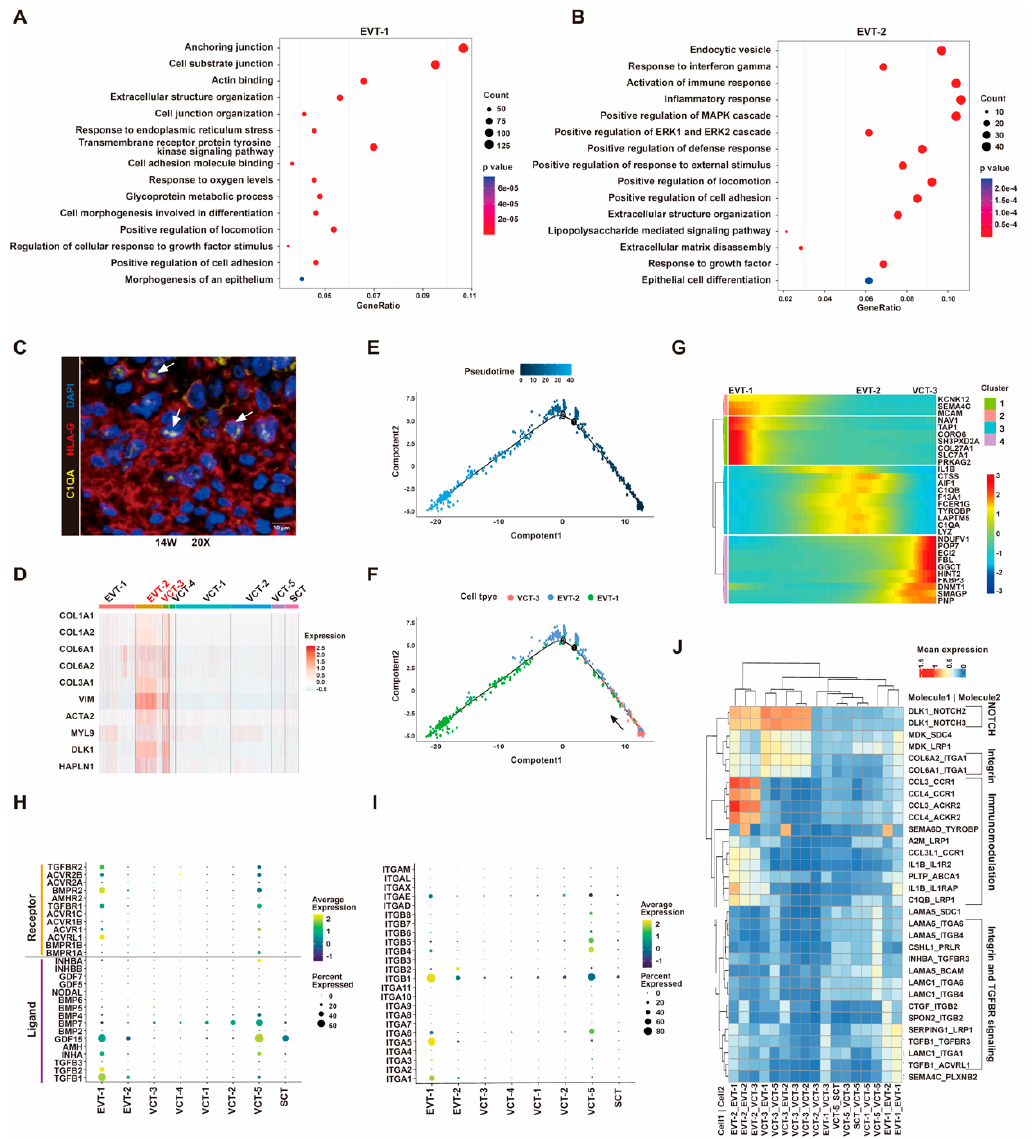
Figure 6. EVT subtypes and VCT to EVT differentiation analysis. ( A , B ) GO analysis of differentially expressed genes of EVT1 ( A ) and EVT2 ( B ). The size of the circles represents the number of signifi- cantly enriched genes in each item. The color key from blue to red indicates low to high average gene expression. ( C ) Immunofluorescence staining for C1QA and HLA-G in the decidua of 14 ges- tational weeks human placenta. The white arrowheads indicate C1QA and HLA-G double positive cells. Scale bars, 10 μ m. ( D ) Heatmap showing the relative expression of EMT genes in each troph- oblast cluster. ( E , F ) Pseudotime analysis of VCT-3 and EVTs, cells on the tree are colored by pseudo- time ( E ) and cluster ( F ). ( G ) Expression pattern over pseudotime for the top 10 most variable genes were shown on the y -axis. Each column represents one cell. Expression ranged from dark blue (low- est) to red (highest). ( H , I ) The expression of TGF- β signaling pathway ( H ) and integrins ( I ) in troph- oblast clusters. The color key from blue to yellow indicates low to high average gene expression, respectively. The dot size indicates the percentage of cells expressing a certain marker. ( J ) Ligand- receptor interaction analysis within trophoblast clusters. Molecule 1 is expressed by Cell 1 and Mol- ecule 2 is expressed by Cell 2.